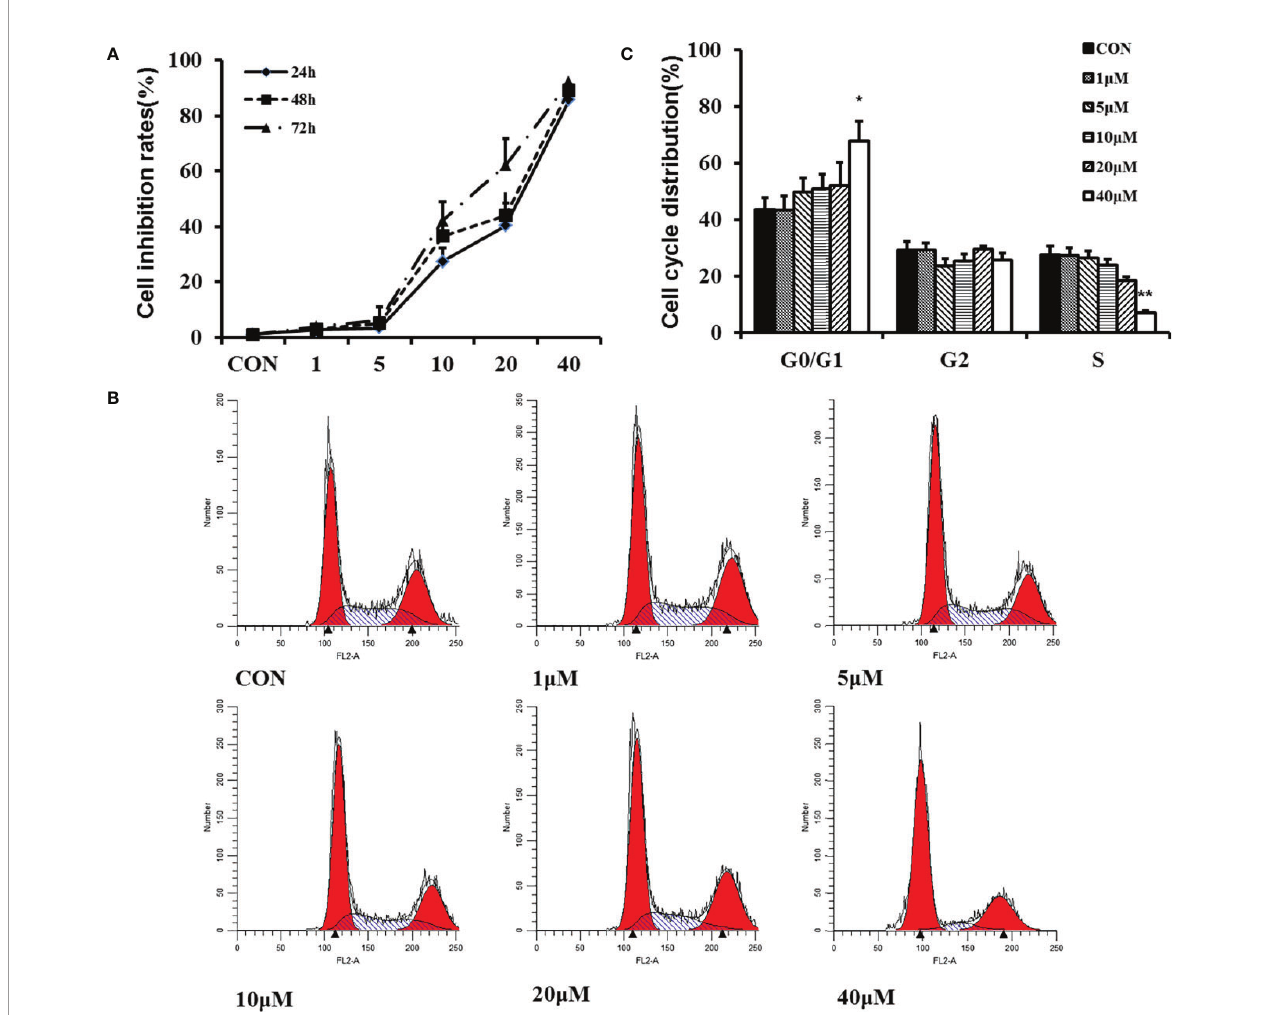
FIGURE 3 | Effect of TMP on proliferation of HFs. (A) Cell proliferation was measured by the CCK-8 assay. HFs were seeded into 96-well plates at a density of 5×10 3 cells per well and treated with various concentrations (1, 5, 10, 20, and 40 µM) of TMP for 24, 48, and 72 h, respectively. (B) Flow cytometry analysis showing the effect of TMP on cell cycle distribution. (C) Histogram summarized the results of (B) . Cell numbers at G1, G2, and S phases were counted and the percentage was calculated. Error bars represented means ± SD of n = 4. * p < 0.05and ** p < 0.01 vs. control group. TMP, tetramethylpyrazine; HFs, HS-derived fi